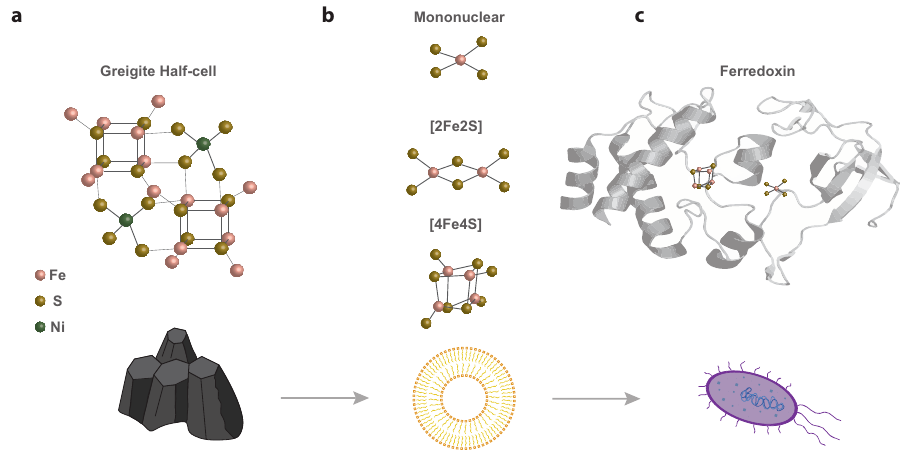
Fig. 1 Similarity of FeS cluster structure in mineral, synthetic and biological forms. a Half-cell structure of the FeS mineral greigite with [4Fe4S] units, b synthetic mononuclear [1Fe0S], [2Fe2S], and [4Fe4S] FeS clusters amenable to protocell incorporation, and c bacterial ferredoxin-thioredoxin reductase (PDB code: 1DJ7 [10.2210/pdb1DJ7/pdb]) structure containing mononuclear [1Fe0S] and [4Fe4S] clusters. For chemical structures: Fe atoms are pink, S are yellow and Ni are